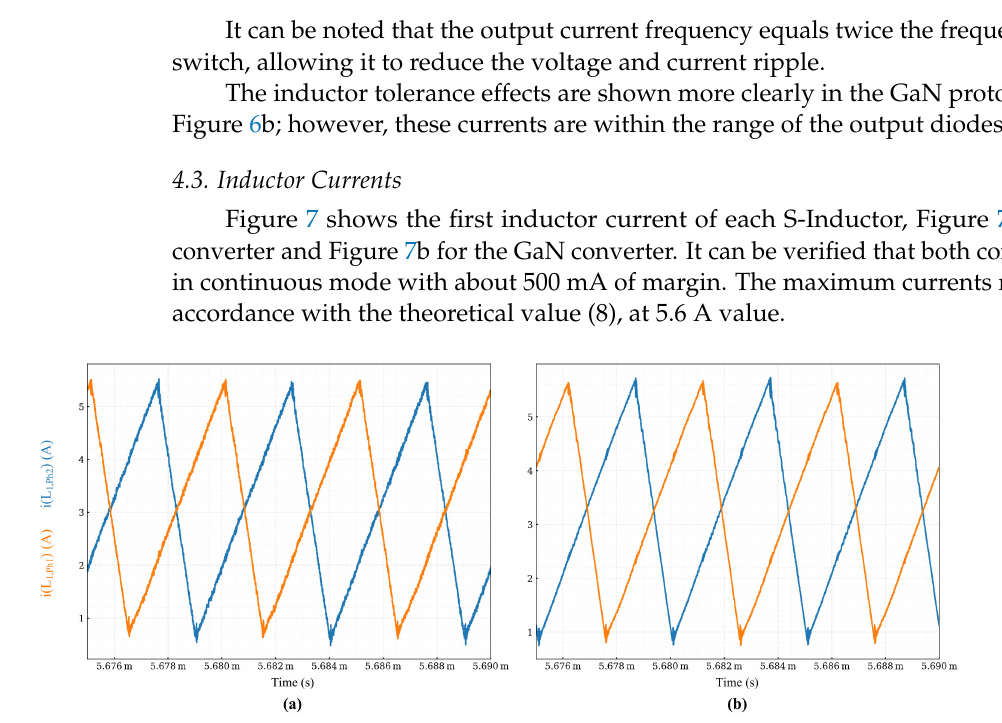
Figure 7. Converter waveforms: ( a ) SiC switch converter (SCT3120ALHR). In orange current i(L 1,Ph1 ) (2 A/div); in blue i(L 1,Ph1 ) (2 A/div). Time scale 2 µ s/div. ( b ) GaN switch converter (TP65H035WSQA). In orange current i(L 1,Ph1 ) (2 A/div); in blue i(L 1,Ph1 ) (2 A/div). Time scale 2 µ s/div.